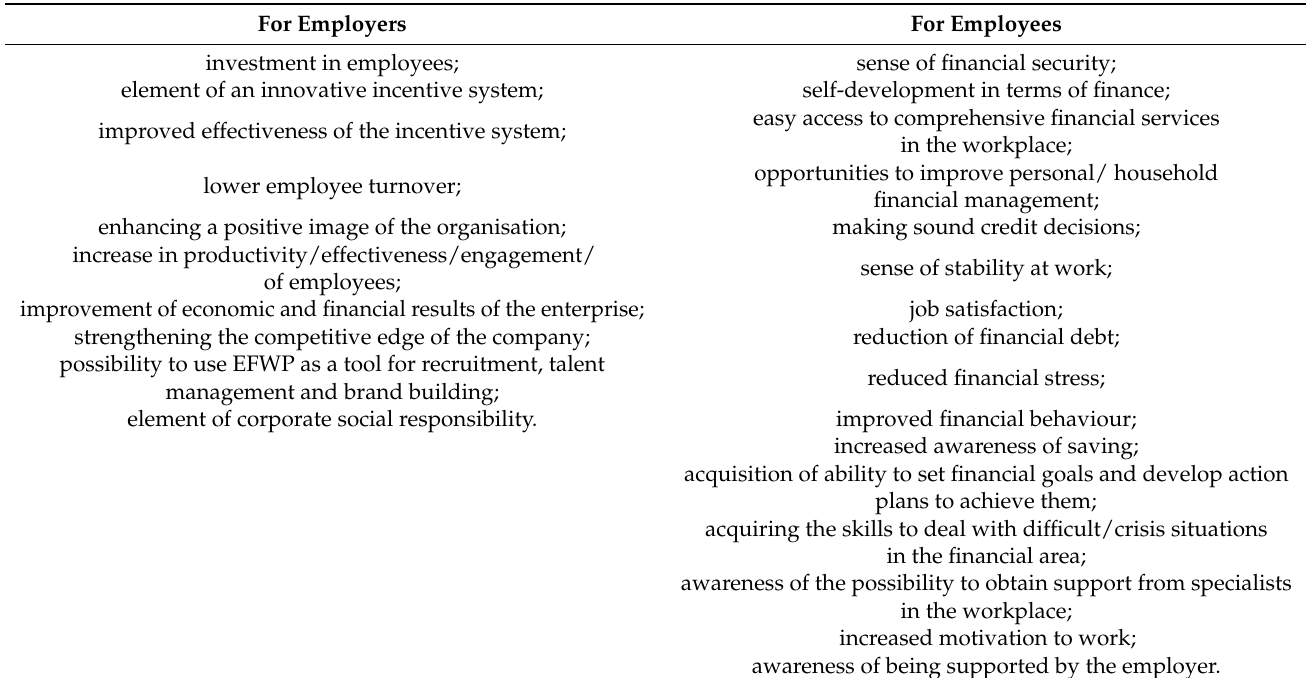
Table 2. Potential benefits of implementing